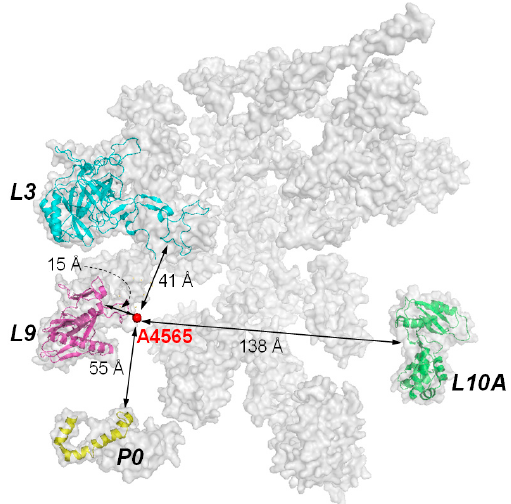
Figure 5. Ribosomal subunits that have been found to interact with RIPs. Subunits P0, L3, and L9 are clustered on a plane and within the vicinity of the targeted adenine. Subunit L10A is almost at the opposite side of the other three subunits. The interaction with the former three ribosomal subunits may be more relevant to the biological activity of RIPs, as variants of TCS with reduced interaction with P proteins are less active in ribosome-inactivation. Model of mammalian ribosome is according to PDB, code 2ZKR.